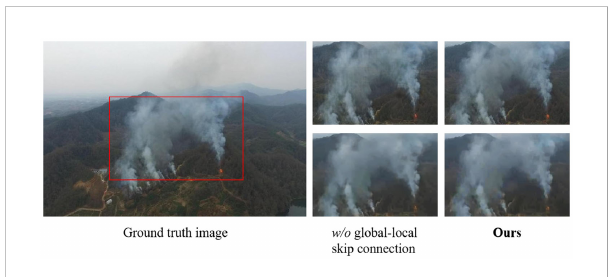
FIGURE 8 Examples on image dehazing( fi rst row) and all-in-one image enhancement(second row) to show the superiority of global-local skip connection. Obviously, our model with glob-local skip connection improves the gridding artifacts and produces much better